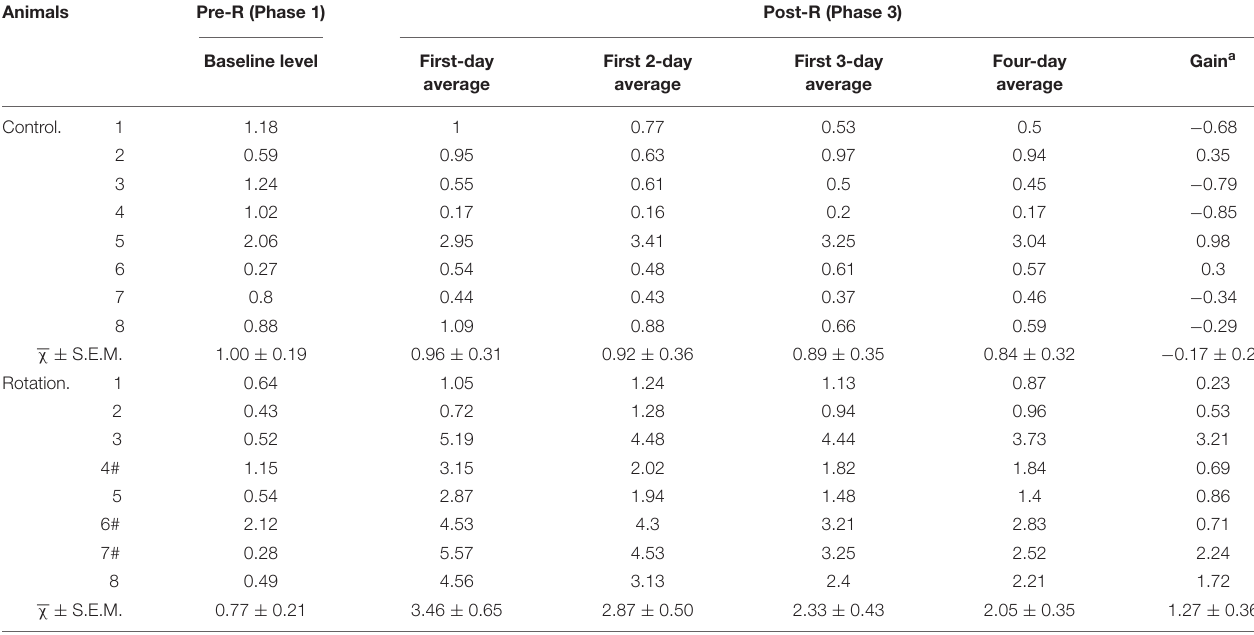
TABLE 1 | Daily kaolin intake (KI) (g/day) of rats in control (pseudo-stimulation) and rotation groups, measured on a 24-h basis for 4 consecutive days in either Pre-R (Phase 1) or Post-R (Phase 3) sessions (mean ± SEM). Pre-R (Phase 1)